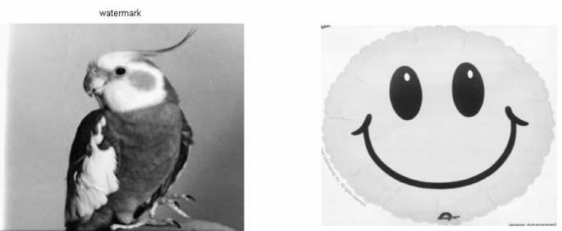
Figure 5. The two different watermarks embedded in the scenes of the video clip.